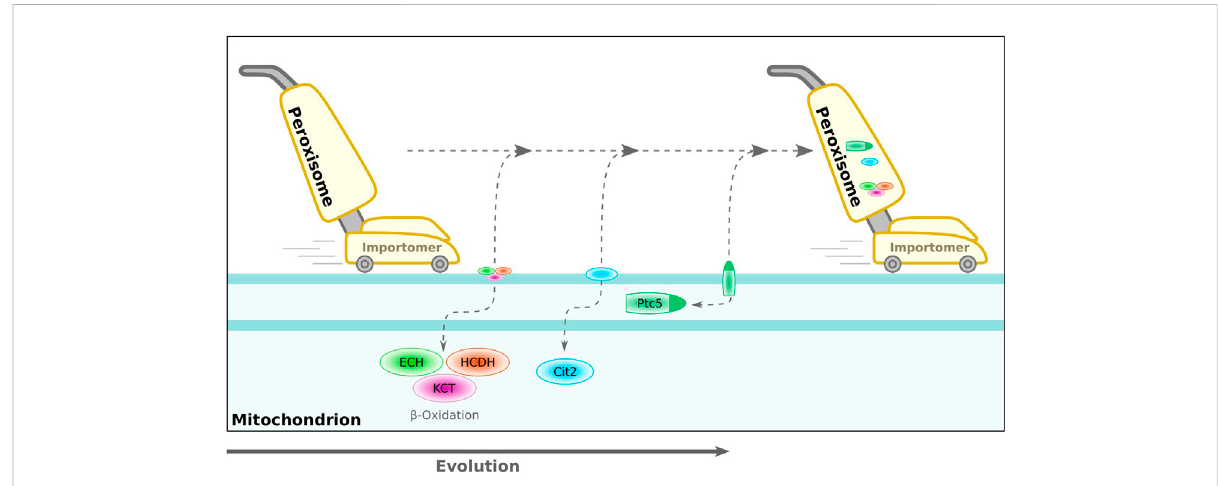
FIGURE 3 Hypothetical model for translocation of proteins from mitochondria to peroxisomes during evolution. Peroxisomes are indicated by a vacuum cleaner — this parallel is inferred from their unique import mode for folded proteins and the possible evolutionary origin of the importomer from an ER-derived quality control system (Gabaldón et al. (2006), Schlüter et al. (2006)). We speculate that over time, various mitochondrial enzymes developed into peroxisomal enzymes via a dually targeted intermediate. Sorting of the phosphatase Ptc5p from S. cerevisiae shows hallmarks for such an evolutionary scenario. ECH, enoyl-CoA hydratase; HCDH, 3-hydroxyacyl-CoA dehydrogenase; KCT, 3-ketoacyl-CoA-thiolase; Cit2, citrate synthase 2 ( S. cerevisiae ); Ptc5, PP2C-type phosphatase ( S. cerevisiae